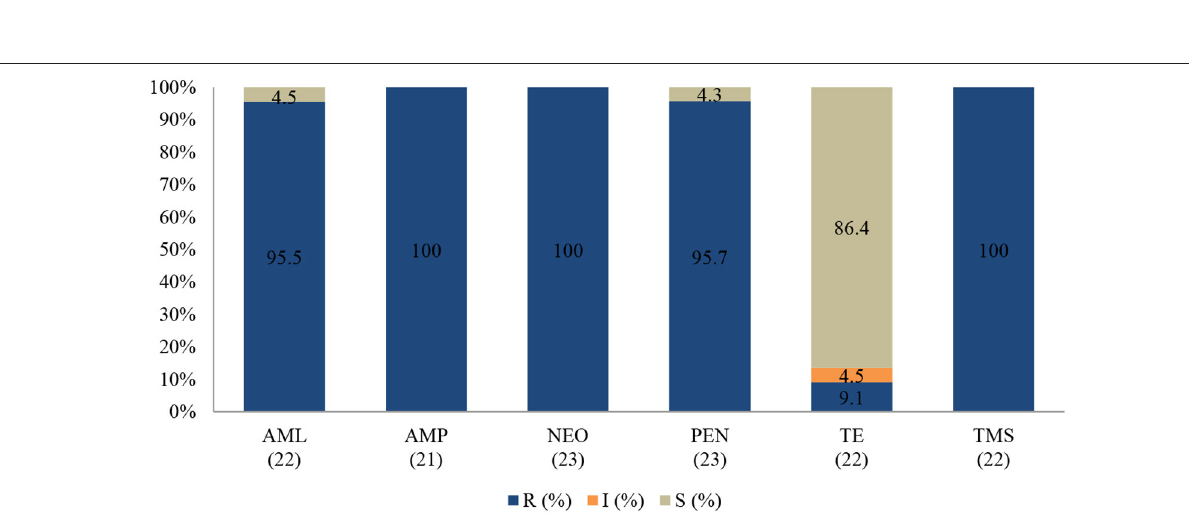
FIGURE 4 | Antibiotic susceptibility pattern of Coagulase-negative Staphylococcus spp. isolates from diseased ruminants (January 2015-December 2017). R-resistance; I-intermediate; S-susceptible; AML-amoxicillin; AMP-ampicillin; NEO-neomycin; PEN-penicillin; TE-tetracycline; TMS-trimethoprim/sulfamethoxazole; Numbers inside brackets “()” indicate total number of tested isolates for each